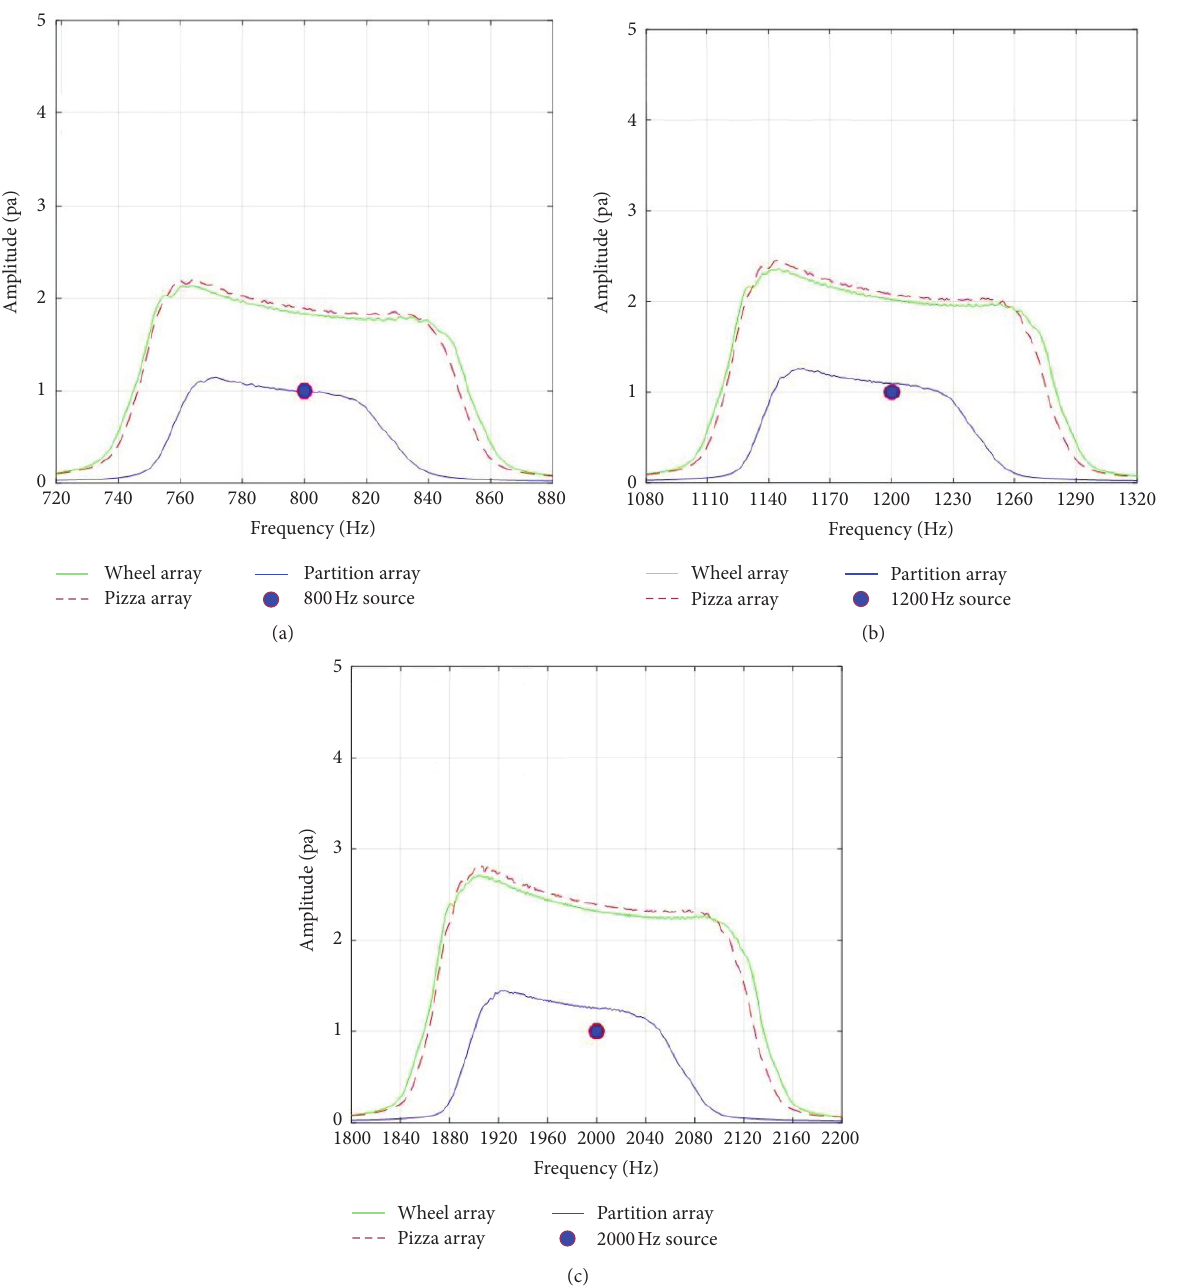
Figure 11: Median spectrum of three arrays of frequencies: (a) 800Hz; (b) 1200Hz; (c)